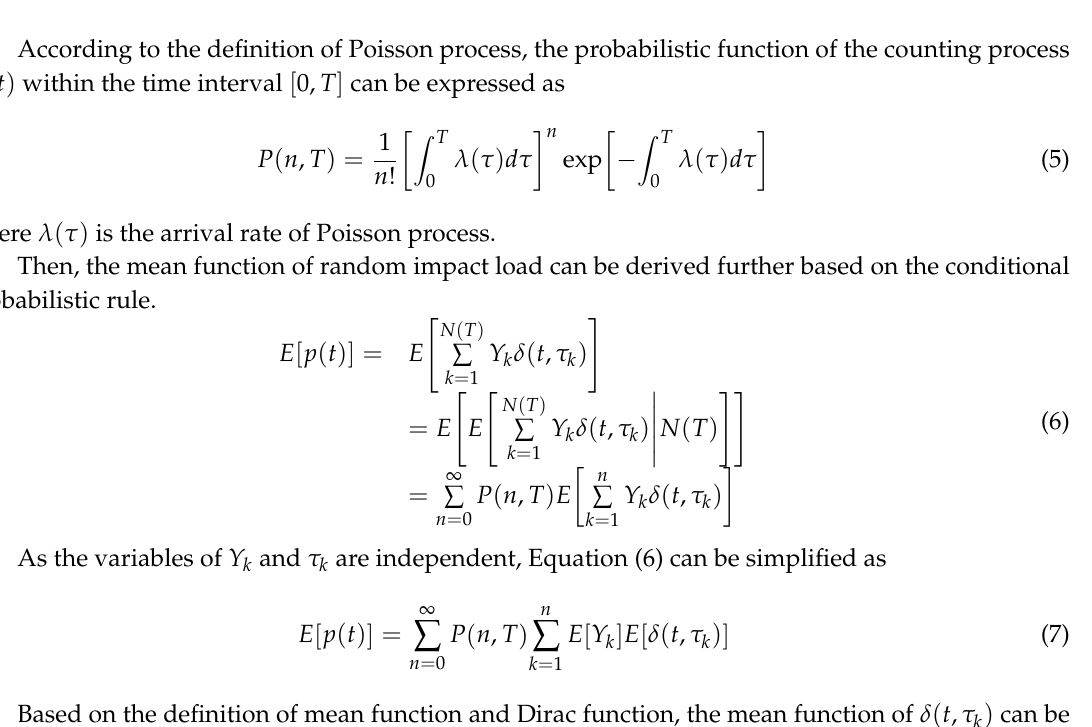
Figure 2. The model of random pulse impact load.